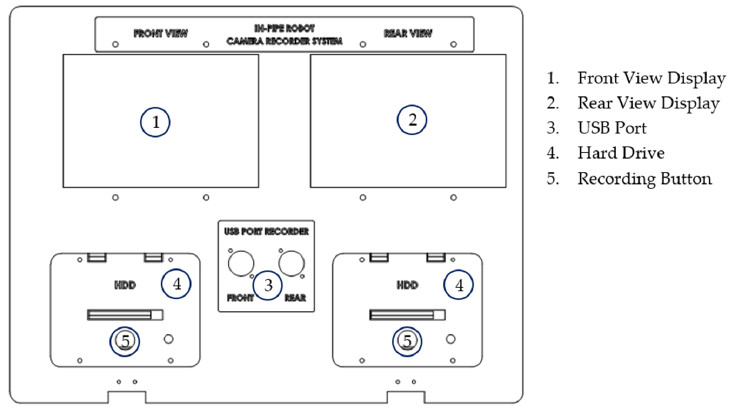
screen panel. The touch screen panel displays the internal temperature and humidity of each robot module and the robot’s speed.